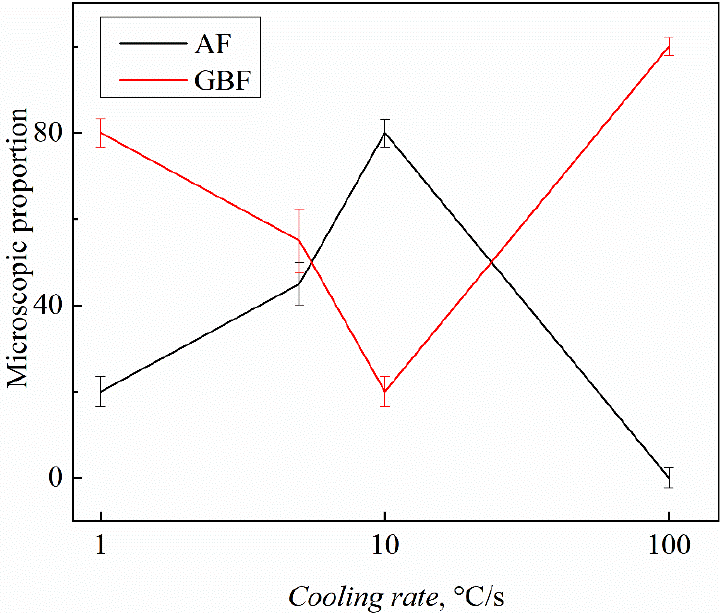
Figure 3. The microscopic proportion of AF and GBF in the weld metal at different cooling rates.